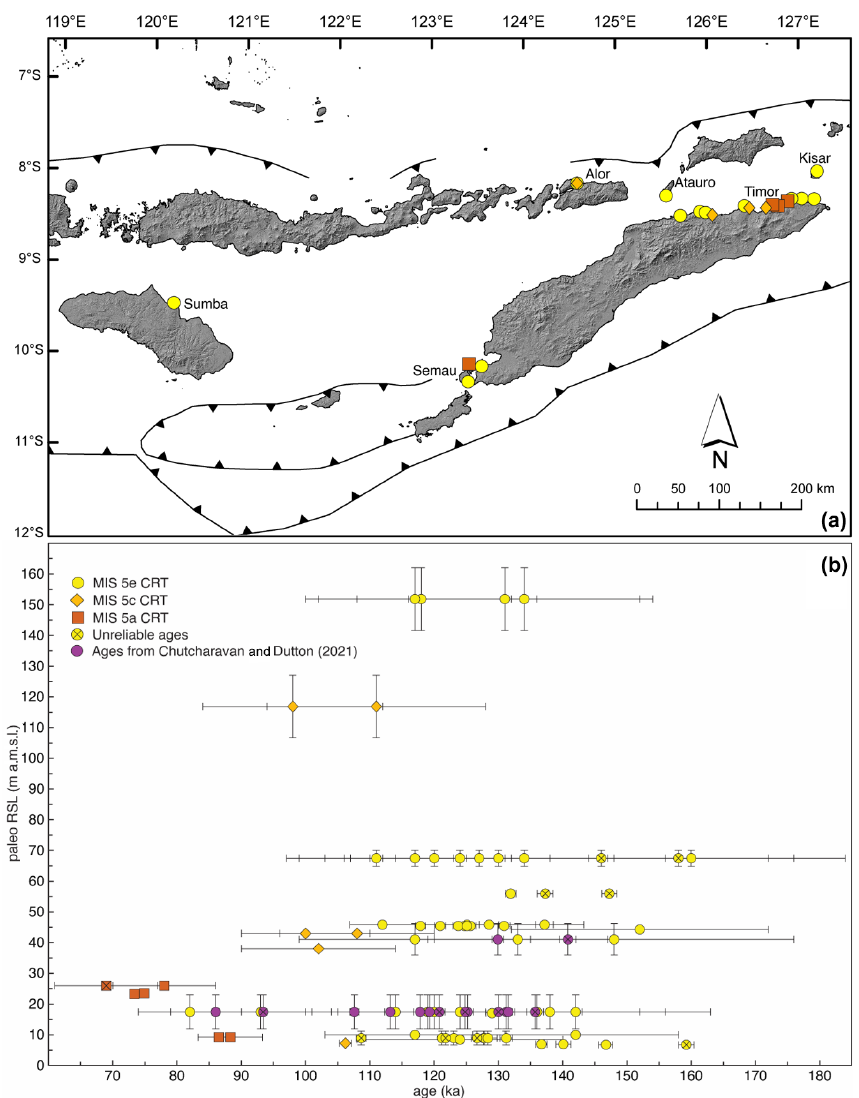
Figure 4. RSL proxies and age–elevation plot of dated corals in the Sumba–Timor–Alor region. (a) Location map of the 22 RSL proxies screened in this study (14 of which are MIS 5e, 4 are MIS 5c, and 4 are MIS 5a). Also shown are the names of the study sites mentioned in the original publications. (b) Age–elevation plot of all the 87 coral samples (including unreliable ones) dated using U-Series and ESR. Shown for reference are ages inserted by Chutcharavan and Dutton (2021), which are all from the coral reef terraces in Sumba Island. Digital elevation model sourced from ASTER Global Digital Elevation Model (GDEM) V003 (NASA/METI/AIST/Japan Spacesystems and U.S./Japan ASTER Science Team,